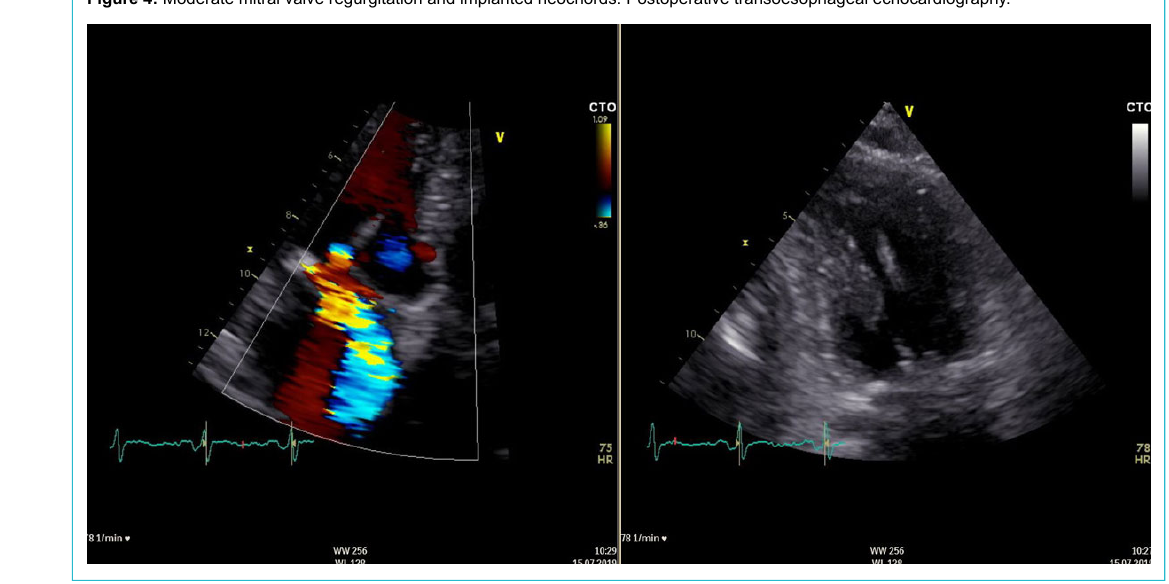
Figure 4: Moderate mitral valve regurgitation and implanted neochords. Postoperative transoesophageal